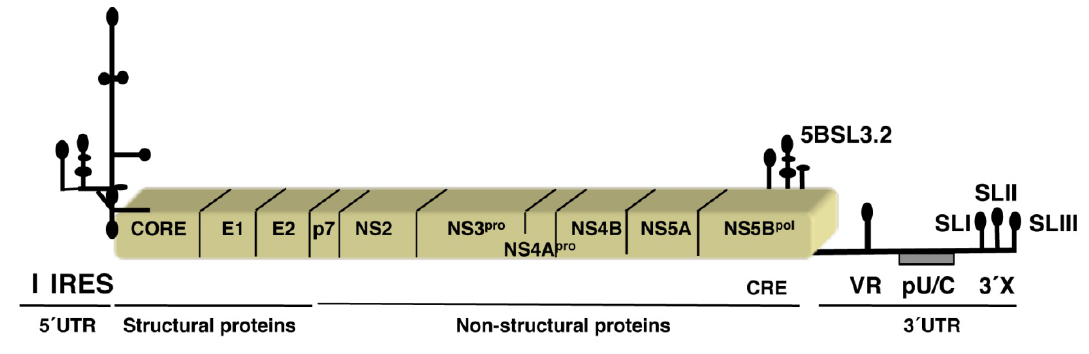
Figure 1. Diagram of the hepatitis C virus genome. Processing of the single polyprotein renders the mature viral proteins Core, E1, E2, p7, NS2, NS3, NS4A, NS4B, NS5A and NS5B. The stem-loop I at the 5' untranslated regions (UTR) and the CRE element located within the coding region of NS5B are required for viral replication. The structural elements of the 3'UTR region referred to in the text (the variable region VR, the polyU/C tract pU/C, and the 3'X region with stem-loops SLI, SLI, and SLIII) are schematically